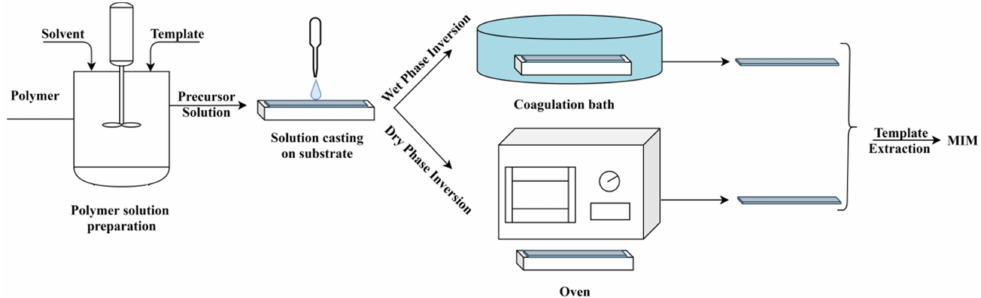
Figure 7. Synthesis of molecular imprinted membranes by phase